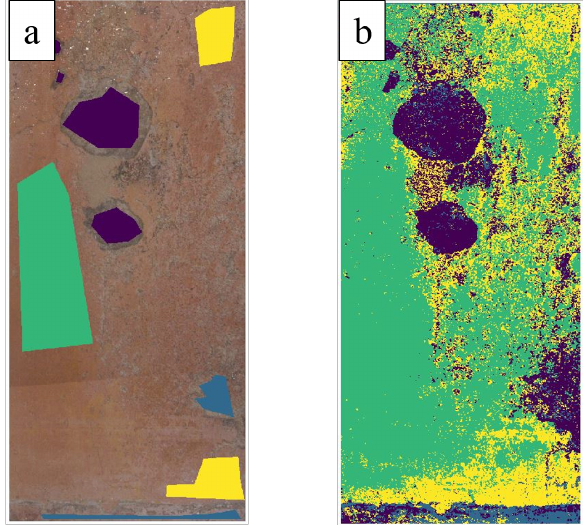
Figure 8. Training areas (a) and resulting classification of orthophoto (b) based on the state of conservation of the wall, obtained with supervised image classification.